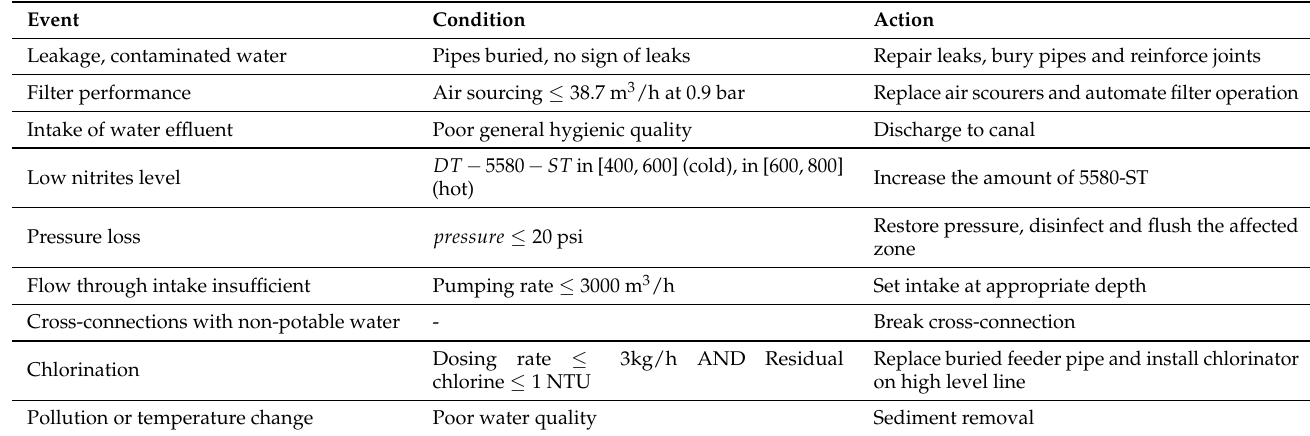
Table 2. Examples of corrective actions for water quality management.